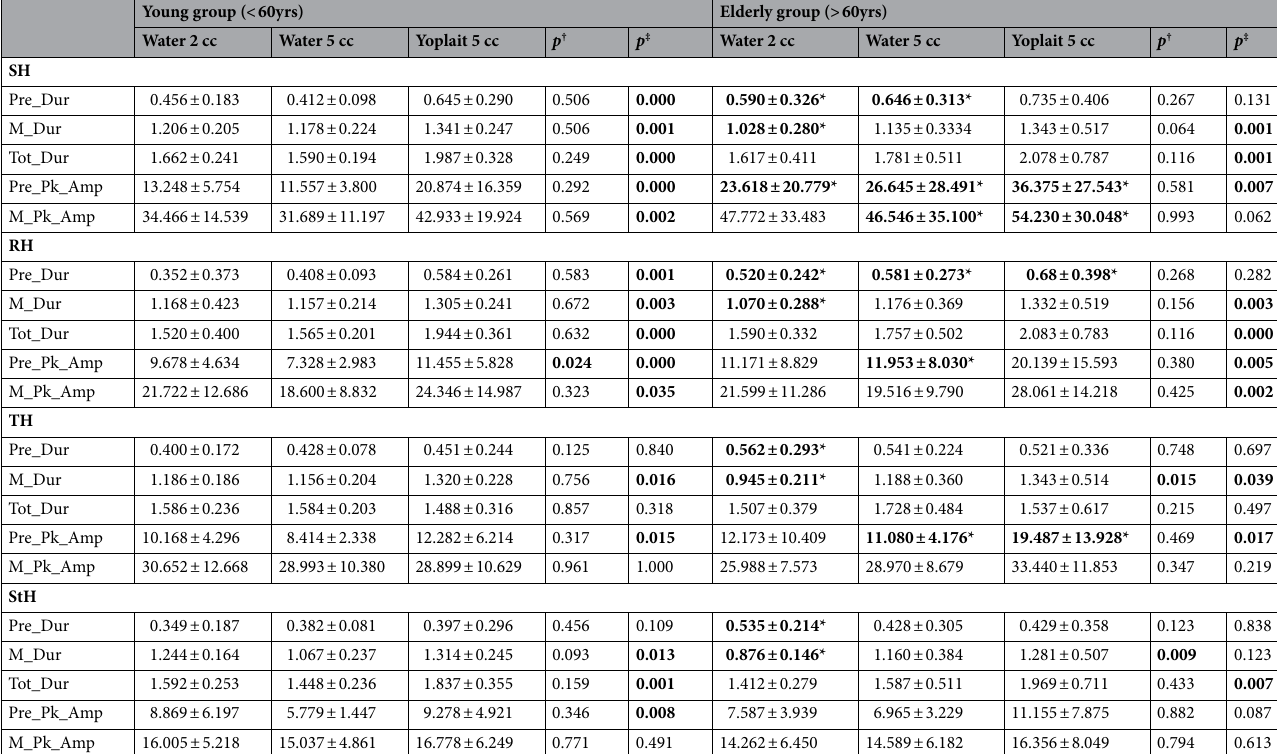
Table 4. Difference of S-EMG variables of type II pattern depending on liquid characteristics in same group. SH; suprahyoid, RH; retrohyoid, TH; thyrohyoid, StH; sternothyroid, Amp; Amplitude, Pre_Dur; pre-reflex duration, M_Dur; main reflex duration, Tot_Dur; total duration, Pre_Pk_RMS; pre-reflex peak amplitude by root mean square, M_Pk_RMS; main-reflex peak amplitude by root mean square, p † ; p -value between water 2 cc and 5 cc swallowing in same group, p ‡ ; p -value between water 5 cc and yogurt 5 cc swallowing in same group. *: The p -value < 0.05 between young group and elderly group in each food